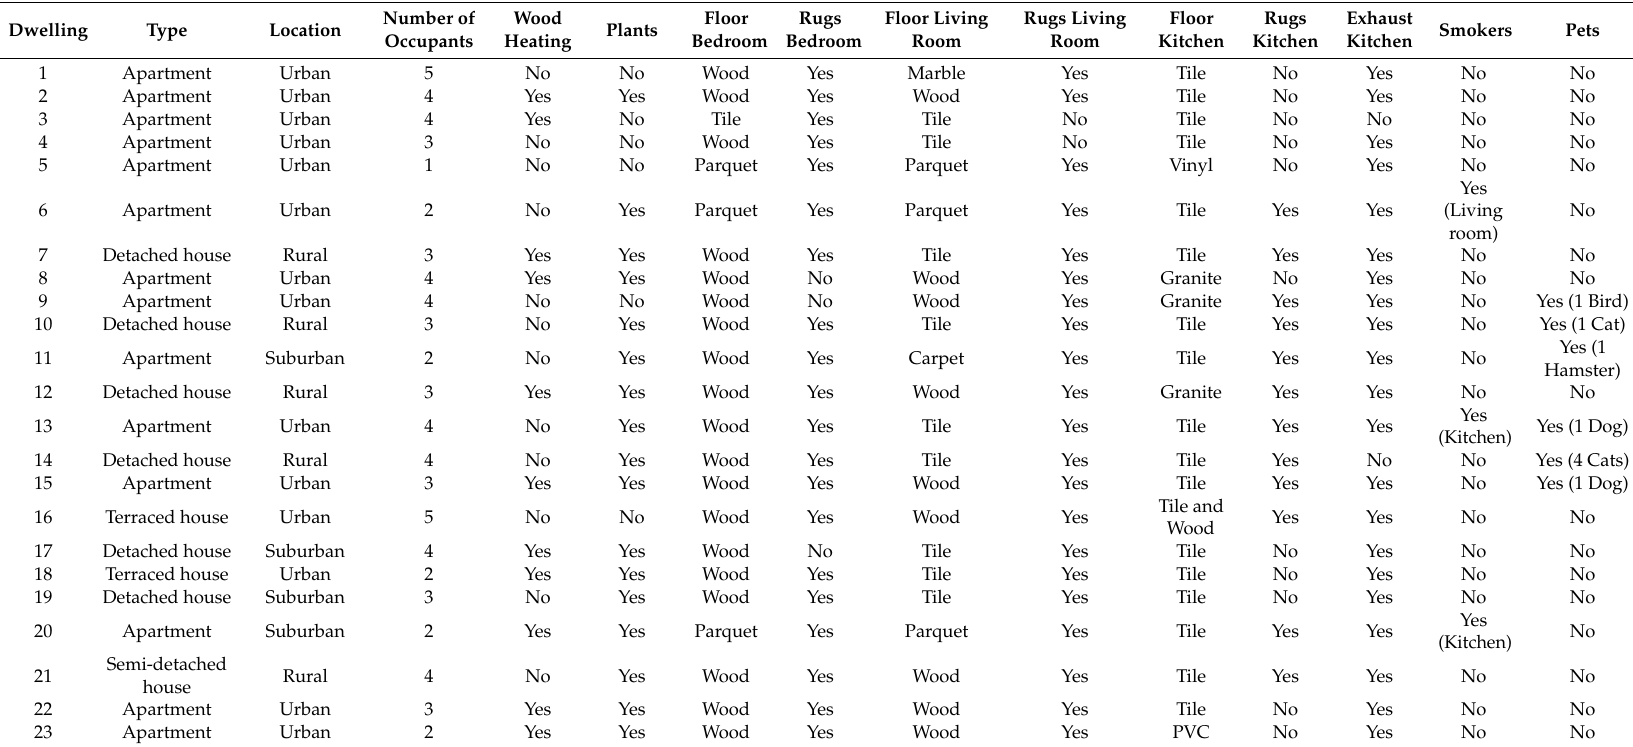
Table 1. Characteristics of the dwellings where dust sampling took